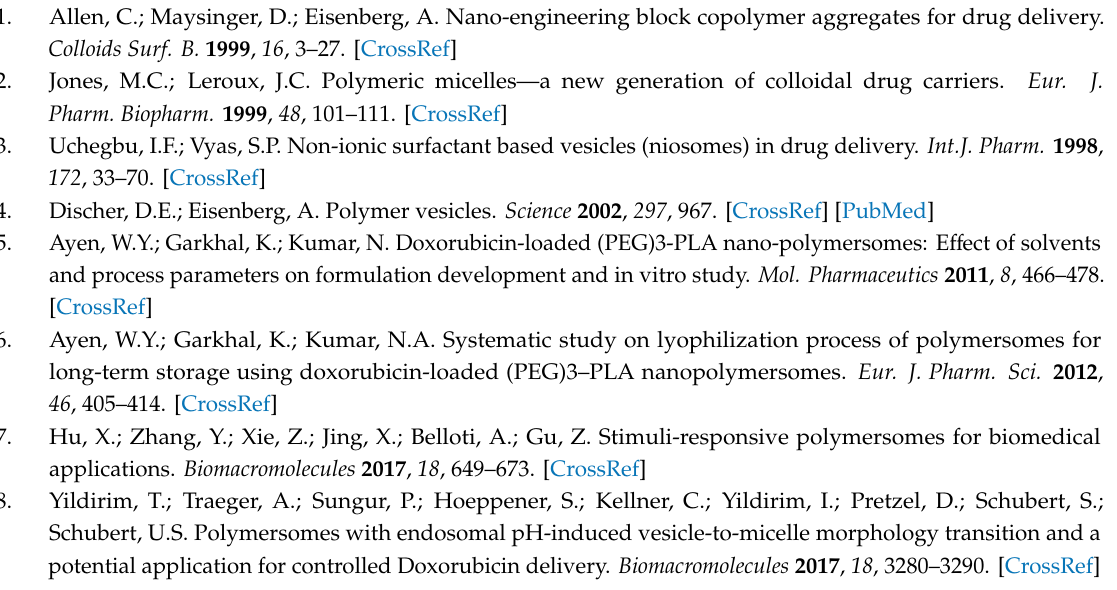
Figure S1: 1 H-NMR spectra for Sigma Aldrich ® methoxy-Poly(ethylene glycol) of (a) 2000 Da and (b) 5000 Da, Text describing of the Synthesis of the PEG 122 -macroCTA in detail, Figure S2: 1 H-NMR (400 MHz, CDCl 3 ) spectra for (a) CTA: 4-cyano-4 (dodecylsulfanylthiocarbonyl) sulfanyl pentanoic acid, (b) PEG 51 -macroCTA, and (c) PEG 122 -macroCTA, Figure S3: (a) UV-Vis spectra of DOX in DMSO at di ff erent concentrations (0–100 µ g / mL) and (b) Calibration curve of DOX in DMSO at 484 nm, Figure S4: (a) UV-Vis spectra of DOX in PBS at di ff erent concentrations (0-30 µ g / mL) and (b) Calibration curve of DOX in DMSO at 484 nm, Figure S5: GPC traces (RALS-detector) of the copolymers P 51 D 47 (PEG 51 - b -PDEAEM 47 ), P 122 D 54 (PEG 122 - b -PDEAEM 54 ), P 122 D 59 (PEG 122 - b -PDEAEM 59 ), P 122 D 87 (PEG 122 - b -PDEAEM 87 ) and P 122 D 96 (PEG 122 - b -PDEAEM 96 ), Figure S6: 1 H-NMR spectra (400 MHz, CDCl DLS distribution of sizes for the P 122 D 96 polymer aggregates obtained by nanoprecipitation in water at di ff erent pH values, Figure S9: TGA-thermograms of synthetized block copolymers: (a) P 51 D 47 , (b) P 122 D 54 , (c) P 122 D 96 , Figure S10: pH sensitive behavior for polymersomes encapsulating gold nanorod AuNR-761: (a) encapsulated with P 51 D 47 ; (b) encapsulated with P 122 D 54 ; (c) encapsulated with from P 122 D 96